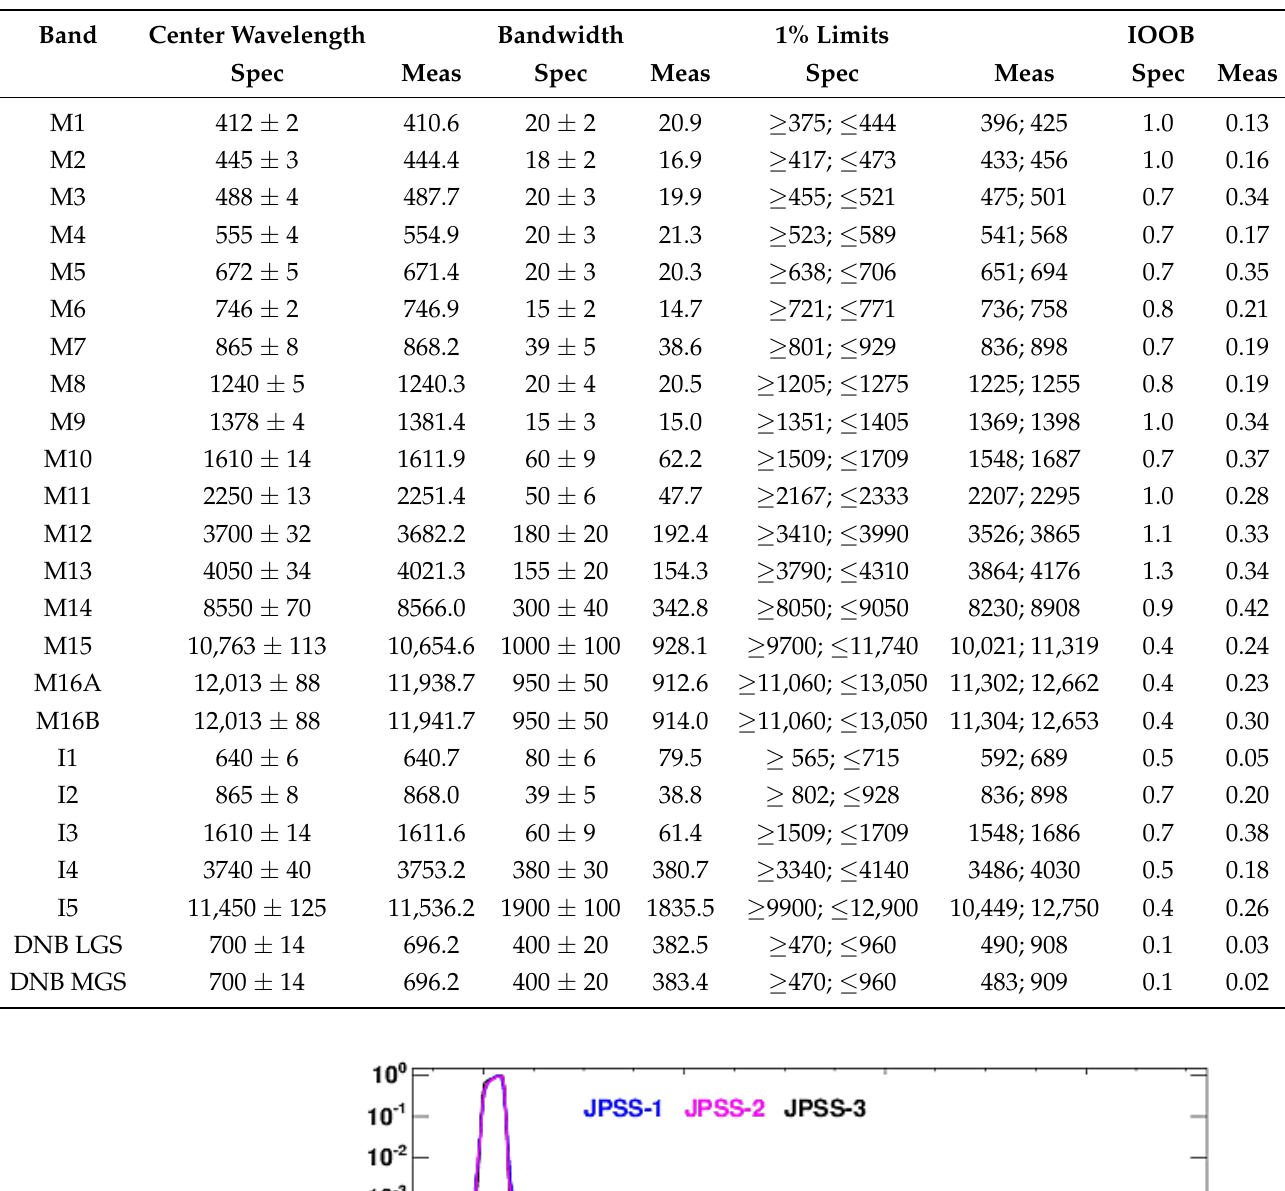
Table 8. JPSS-3 VIIRS RSR relative to the sensor specification [10].